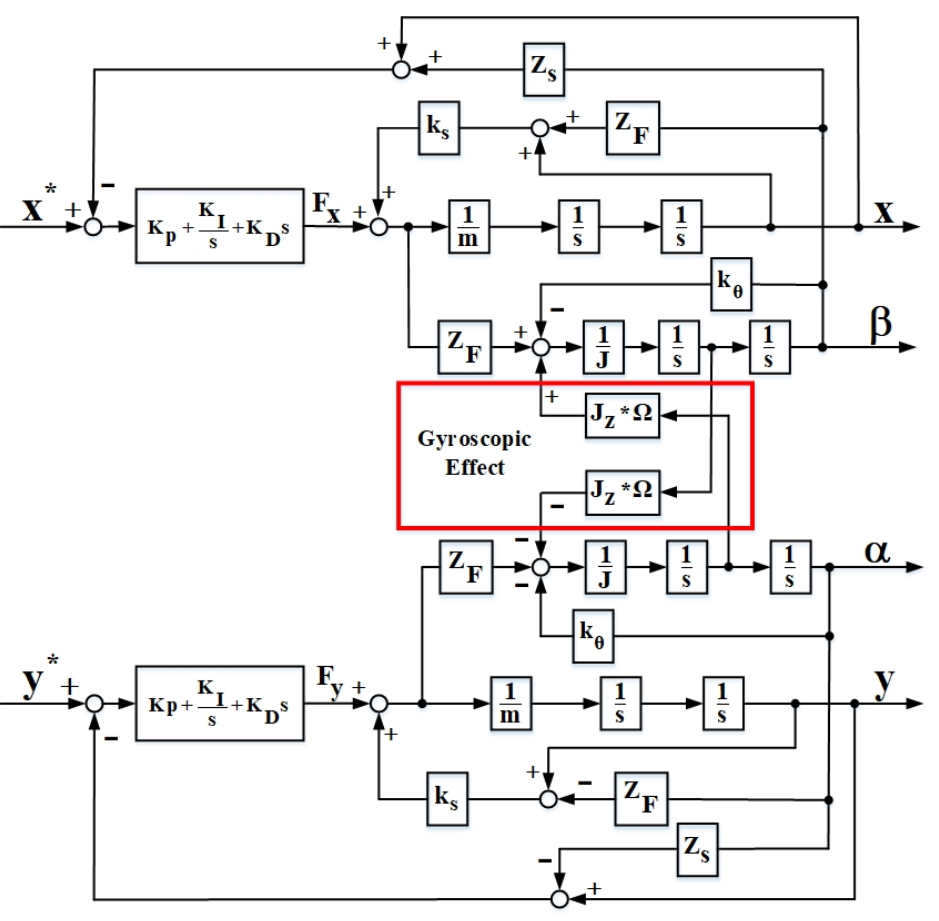
Figure 5. Block diagram of MLSM system considering gyroscopic effect and non-collocated struc- ture.